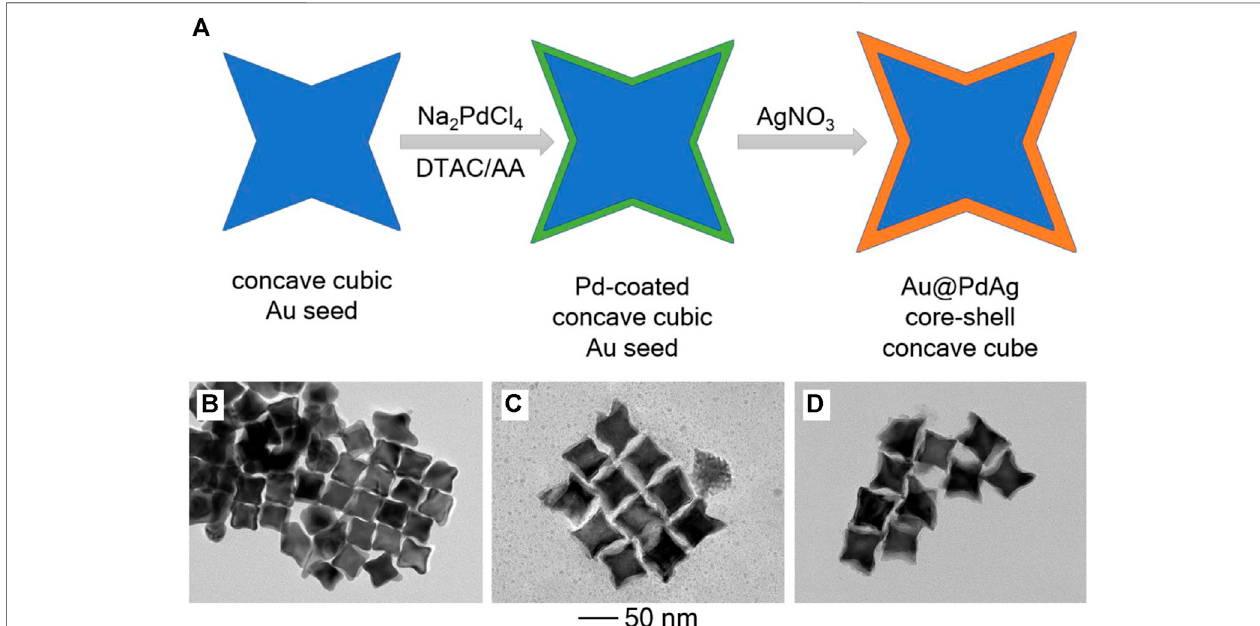
FIGURE1|(A) Schematicillustrationshowingtheconstruction ofAu@PdAgcore-shellconcavenanocubes byconductingsequential conformalgrowthofPdand Ag over concave Au cubic seeds. (B – D) TEM images: (B) concave cubic Au seeds; (C) Pd-coated concave Au nanocubes; (D) Au@PdAg core-shell concave